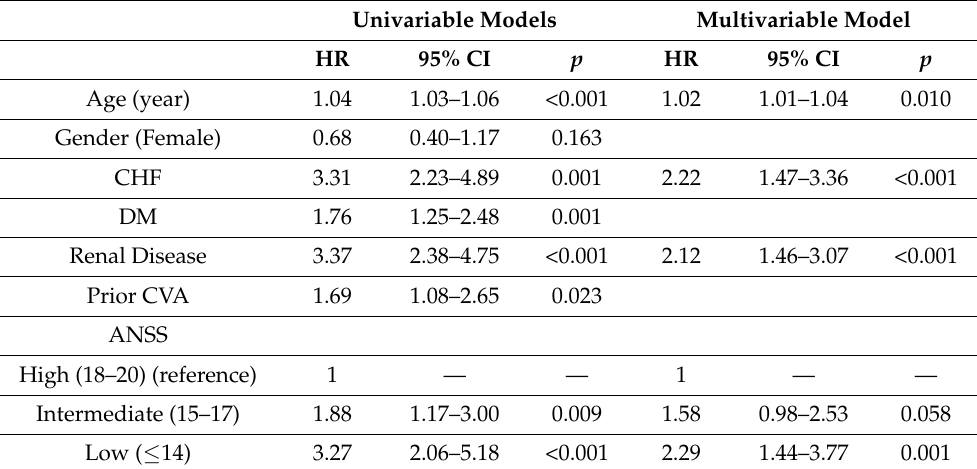
Table 3. COX proportional hazards univariable and multivariable models for death without prior ICD